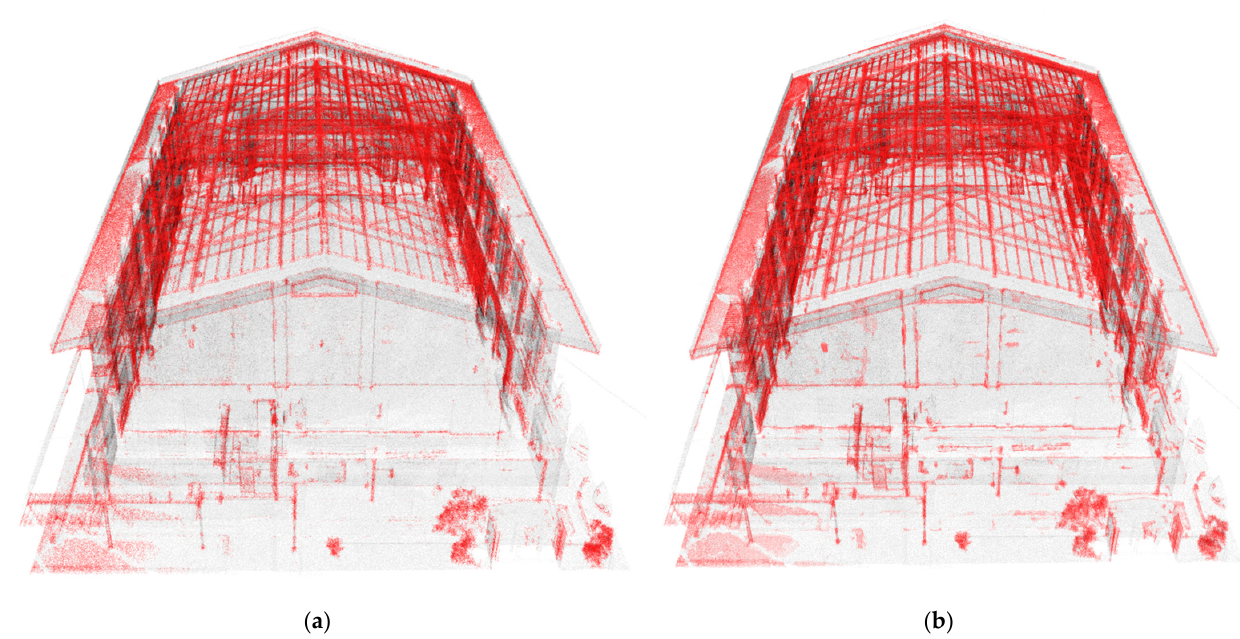
Figure 8. Fused transparent visualization of the original 3D-scanned point cloud with the extracted edge points. ( a ) shows the fusion with the edge points before upsampling, and ( b ) shows the fusion after the upsampling using our proposed network.